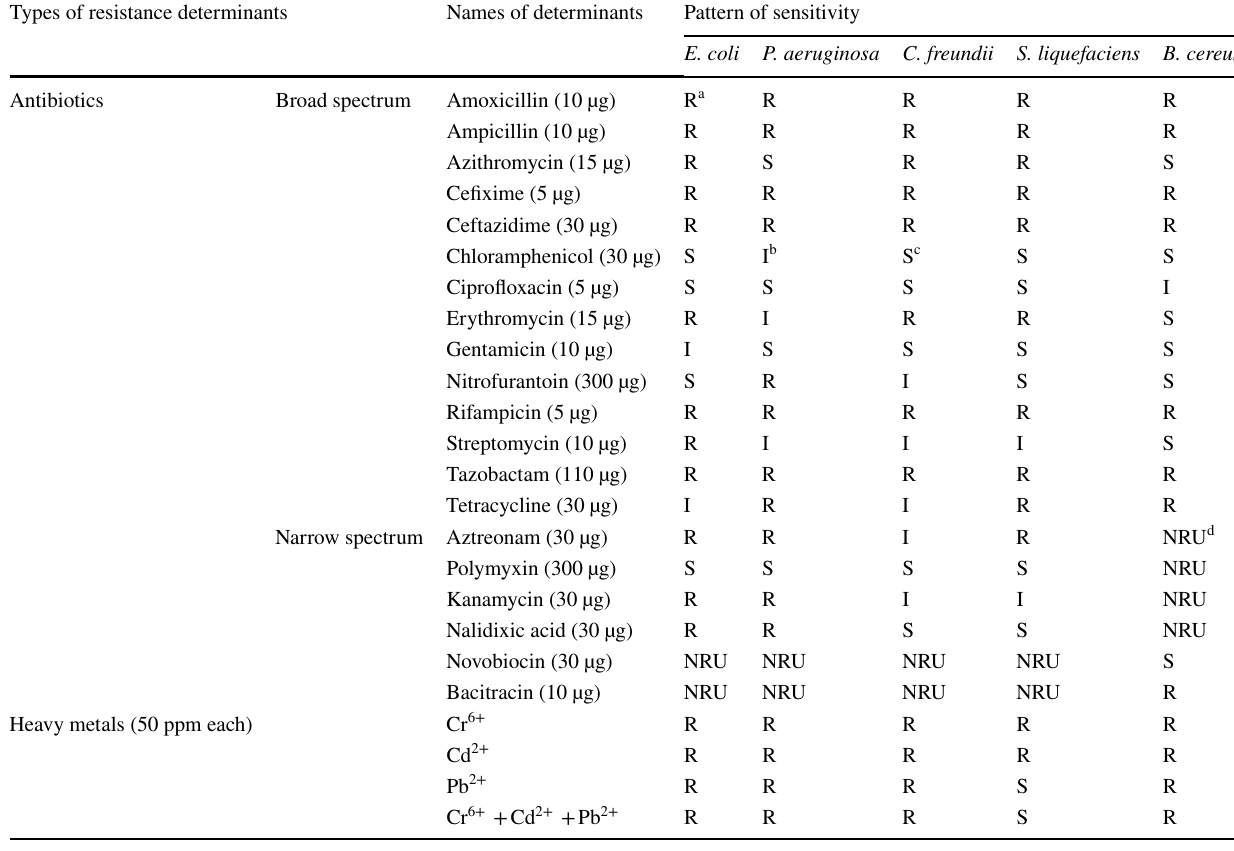
Table 3 Resistance pattern of randomly selected bacterial isolates against multiple antibiotics and heavy